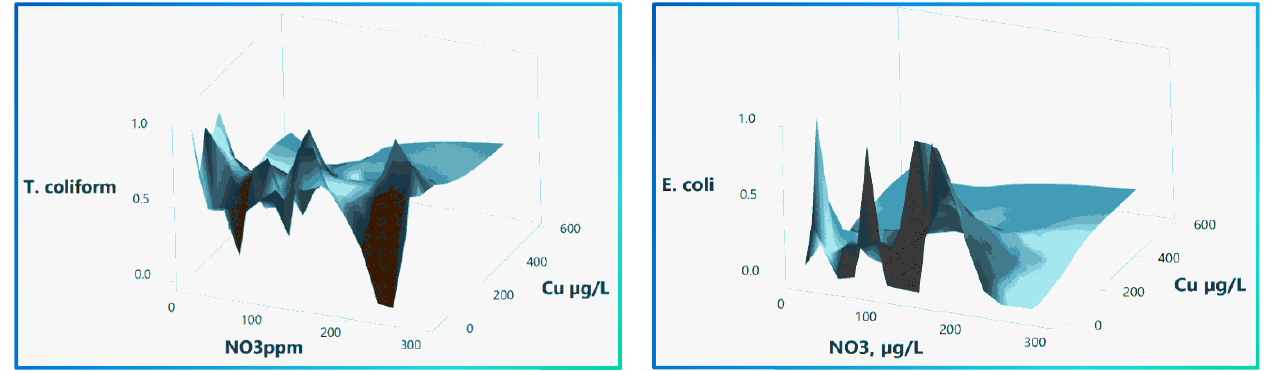
Figure 12. Bubble plot of the Pb and Fe concentrations combined interaction on TC ( blue ) and E. coli ( red ).